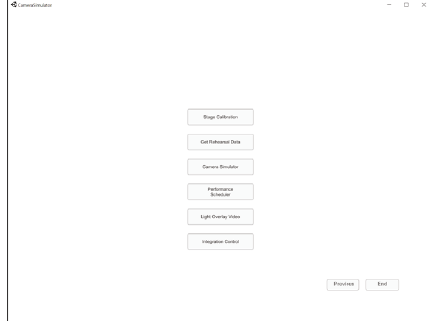
Figure 1: Composition of the developed integrated broadcasting control system to operate the existing shooting system in one